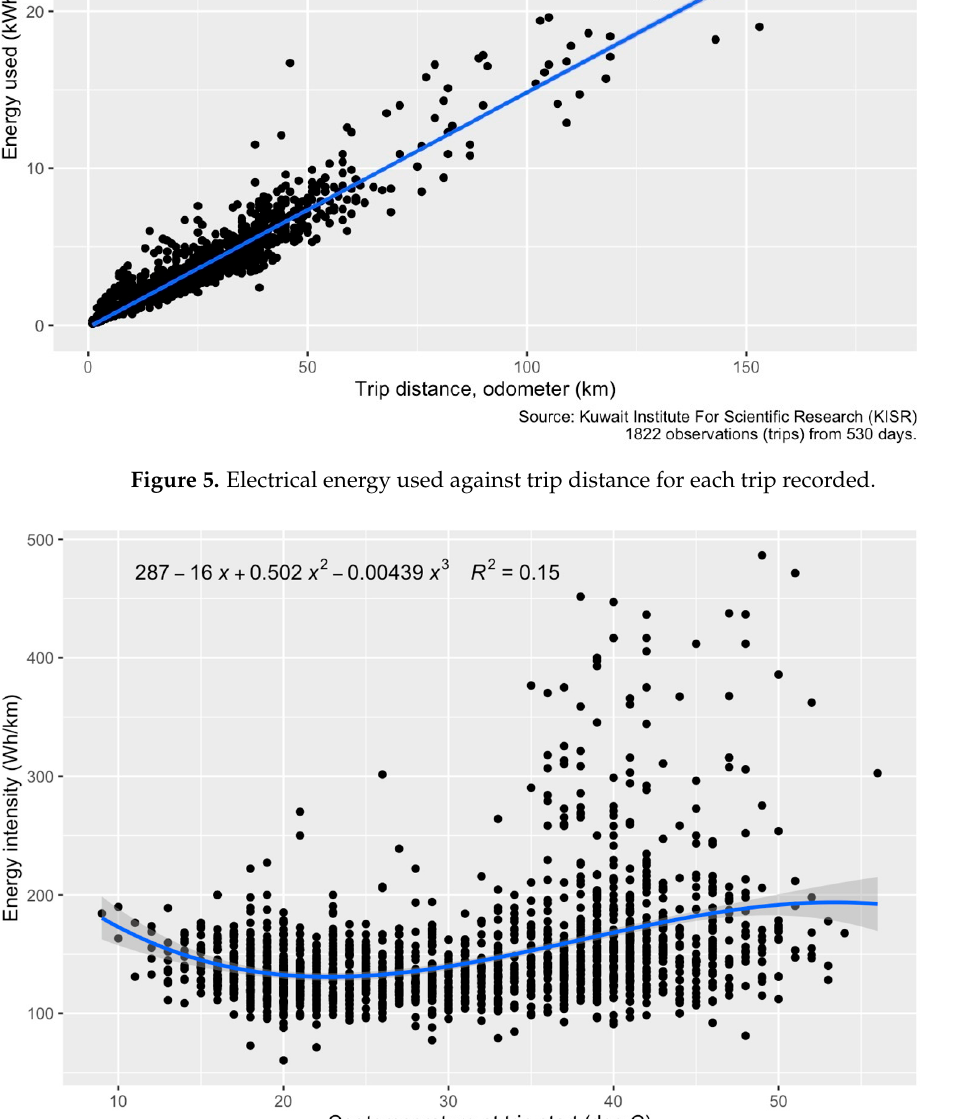
Energies 2022 , 15 , x